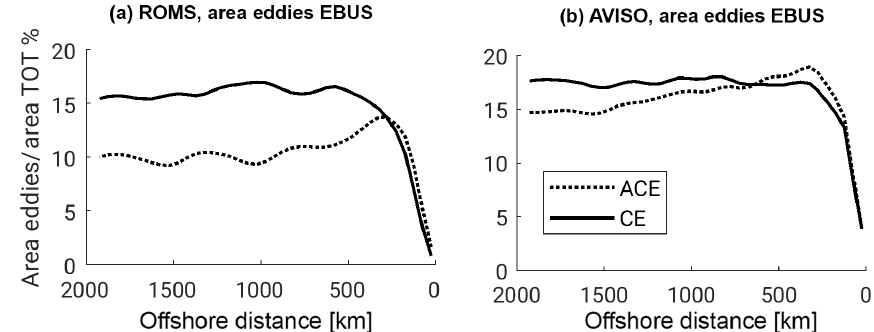
Figure B5. Portion of the CanUS (EBUS) occupied by the eddies, by eddy type. (a) Modeled ROMS eddy field; (b) AVISO eddy